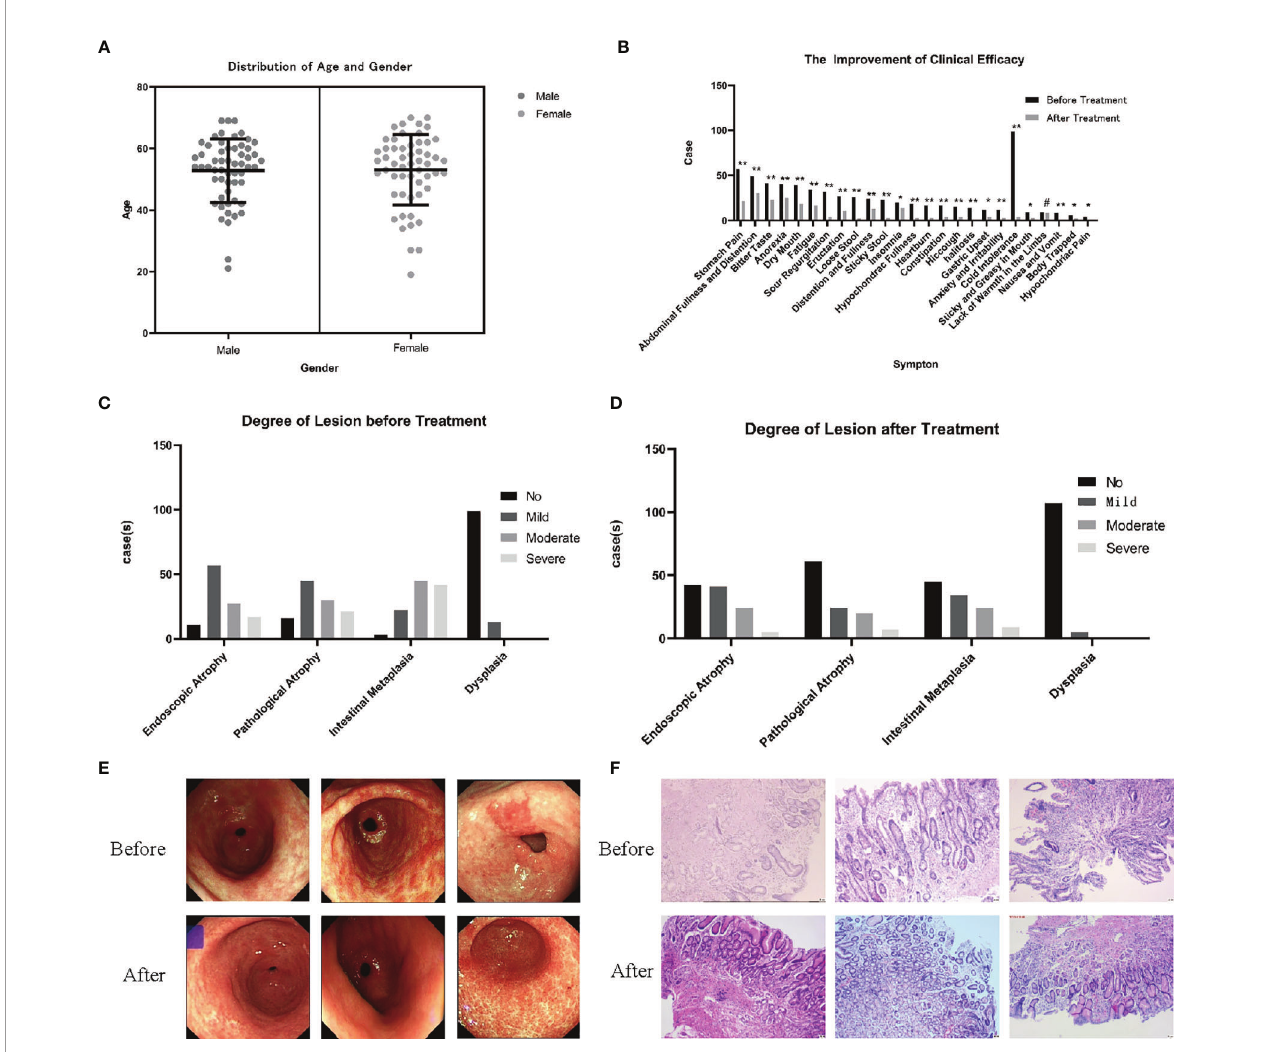
FIGURE 2 | Observation and study on the clinical curative effect in the previous study. (A) Gender and age distribution of 112 patients with PLGC ( P > 0.05). (B) After 6 months of treatment with SCTWD, the clinical symptoms of the patients improved (* P < 0.01, ** P < 0.05, # P > 0.05). (C) Histopathological distribution of patients before treatment. (D) Histopathological distribution of patients after treatment. The histopathological distribution of patients before and after treatment data were analyzed by ANOVA ( P <0.01). (E) Gastroscopic pictures of 3 patients before and after treatment were showed, and all the observation sites were antrum. (F) Histopathological sections of 3 patients before and after treatment were taken from the gastric antrum. Scale bar: 20